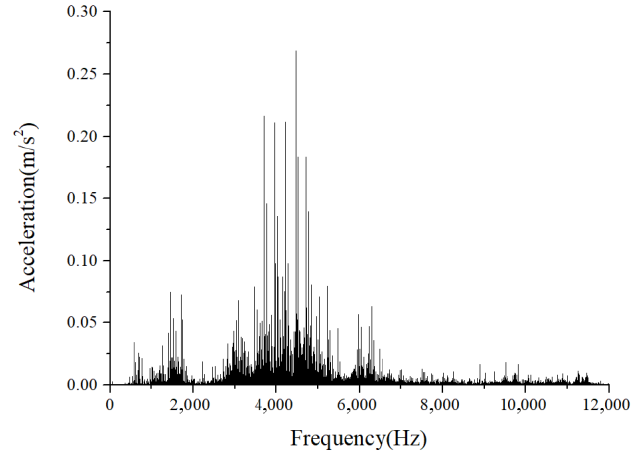
Figure 40. Acceleration spectrum (severe friction). Figure 40. The amplitude spectrum of the test signal (severe friction).